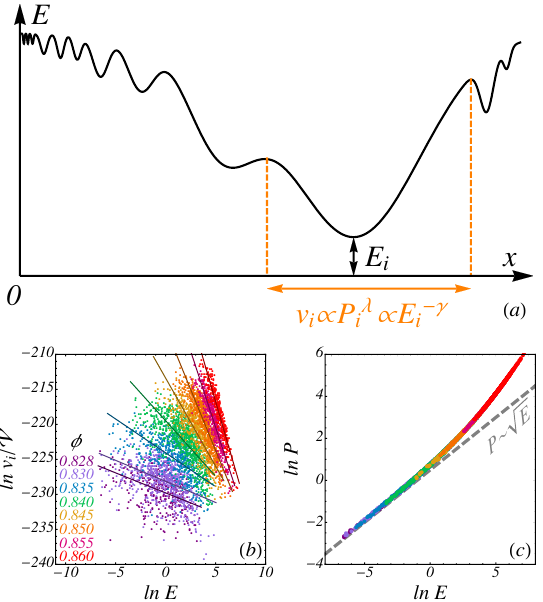
Figure 10: Hierarchical energy landscape of soft sphere packings. ( a ) Sketch: the power law between basin vol- ume, v i , and pressure suggests that a minimum lying at E i > 0 has a basin with volume v i ∝ E − γ with γ i a positive exponent. We verify this scaling relationship in ( b ), using the same data as in Fig. 9. Panel ( c ) shows a smooth dependence of P as a function of E , with an √ E at asymptote P ∝